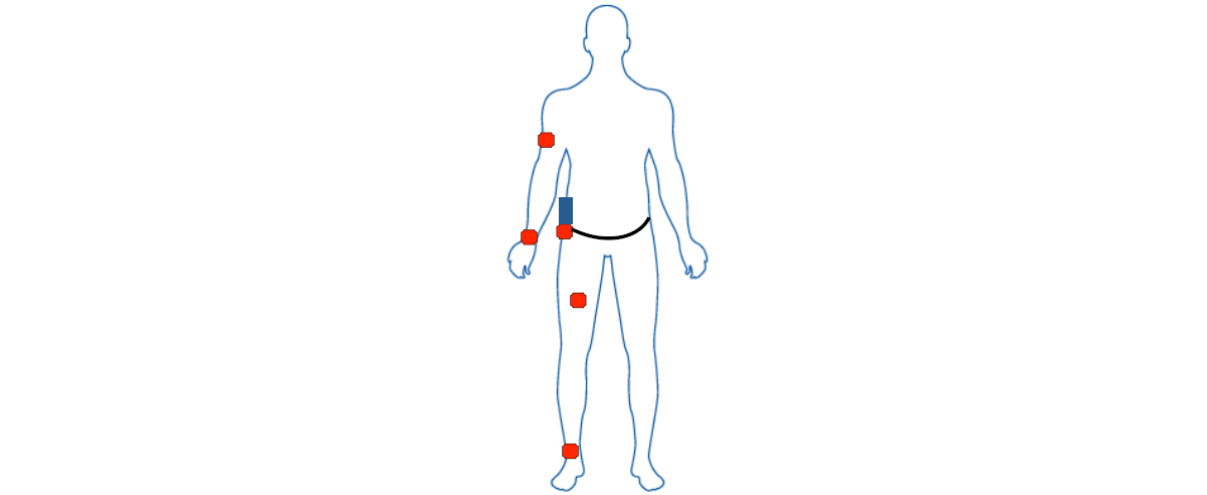
Figure 1. Sensor placement on the